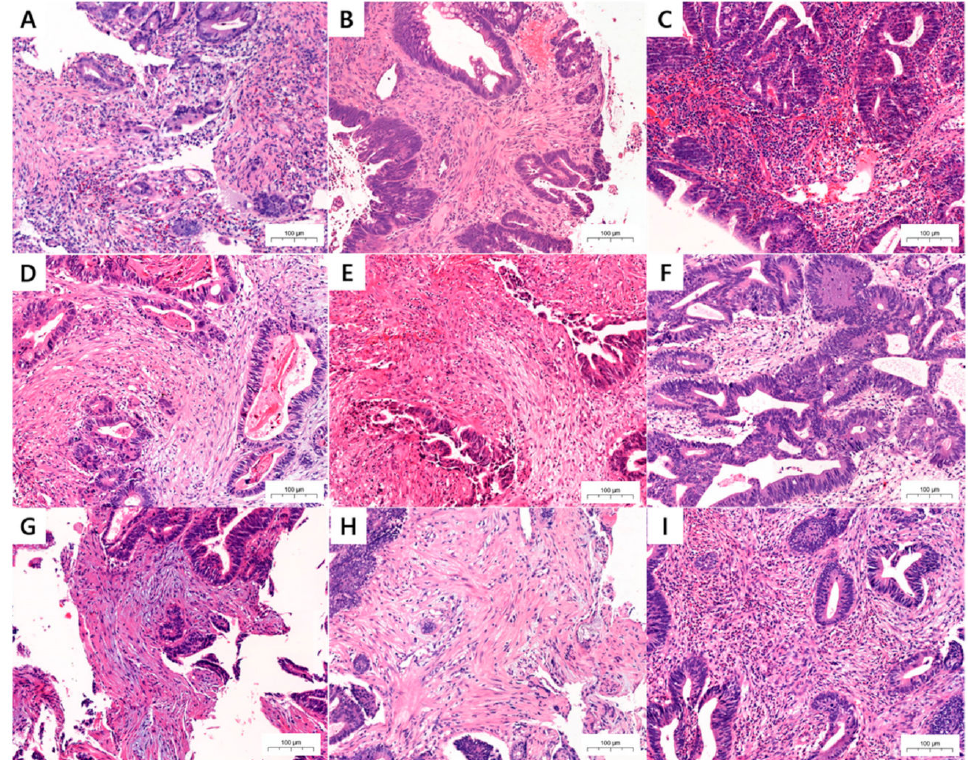
Figure 1. Representative microscopic images of tumor microenvironmental (TME) factors in the pretreatment biopsy samples (PBSs) of colorectal carcinoma (CRC). ( A ) High- and ( B ) low-grade intratumoral budding (ITB). ( C ) Strong and ( D ) weak grade Klintrup–Mäkinen (KM) grade. ( E ) High and ( F ) low ratio of tumor–stromal ratio (TSR). ( G ) Immature, ( H ) intermediate, and ( I ) mature type of desmoplastic reaction (DR). ( A – I , HE staining; 200 ). ×